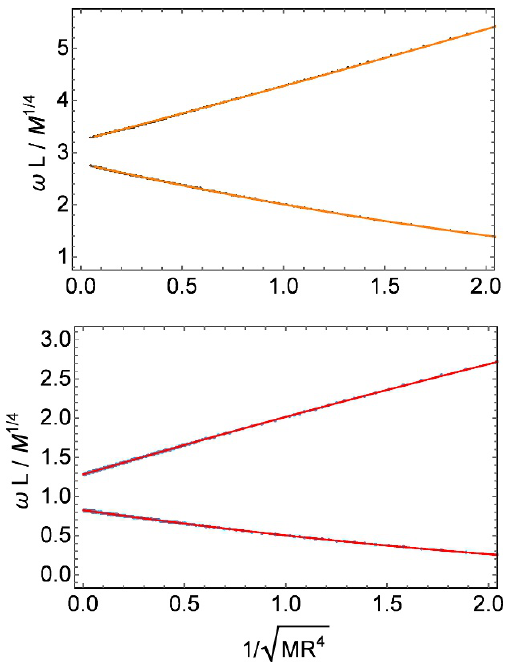
Figure 7 . Lowest (bottom panel) and next-to-lowest (top panel) quasinormal frequencies for the scalar perturbation (cid:30) . The solid (red and orange) lines are the (cid:12)t. horizon. With this second boundary condition the Cauchy problem is well de(cid:12)ned.